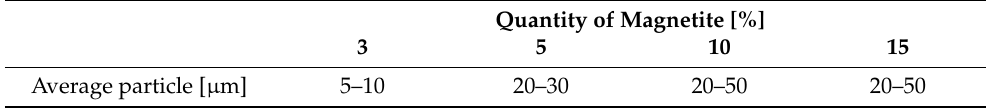
Table 13. Average particle size of noble metals after microwave treatment.